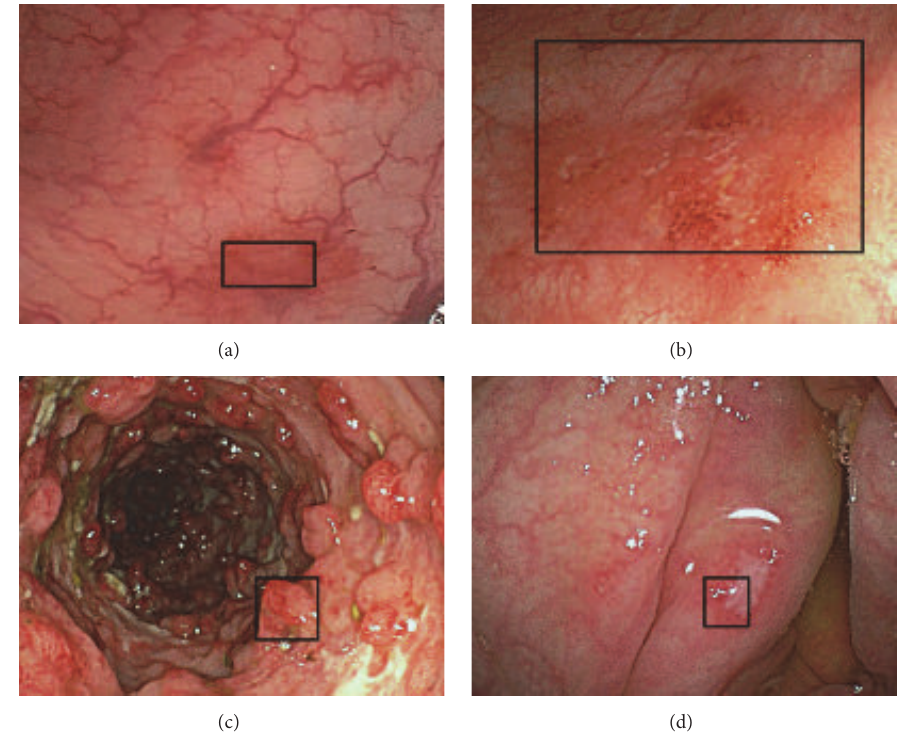
Figure 14: Retrieval results (black rectangles) for four actual target images.